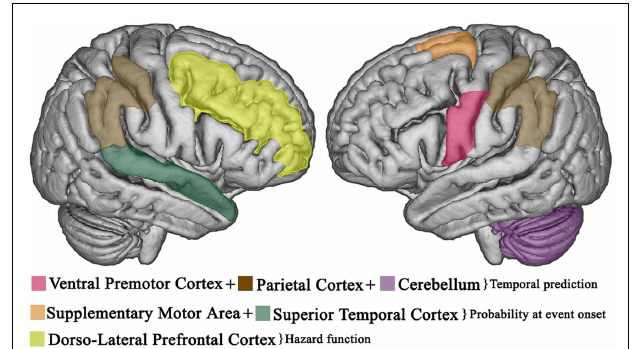
FIGURE 3 |Temporal expectations in the brain . Cortical areas involved in implicit, predictive timing.Temporal expectations, based on temporally predictable sequences, are established in left premotor-cerebellar-parietal action circuits. If the event does not occur at the expected delay, the right prefrontal cortex updates the current temporal expectations as a function of elapsed time (hazard function). Once the event occurs, the supplementary motor area and the superior temporal cortex provide an integrated estimate of how expectations evolved over time to improve the accuracy of future